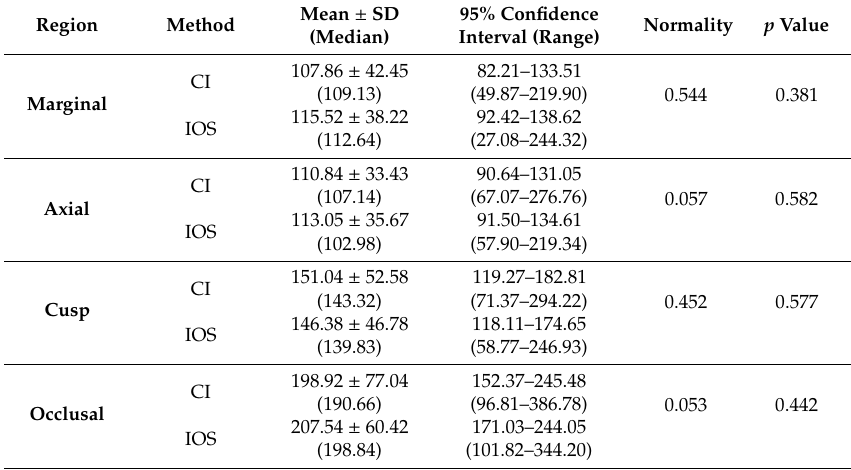
Table 2. Results of the replica measurements in micrometers at four locations: marginal gap, axial wall, cusp tip, and occlusal gap.